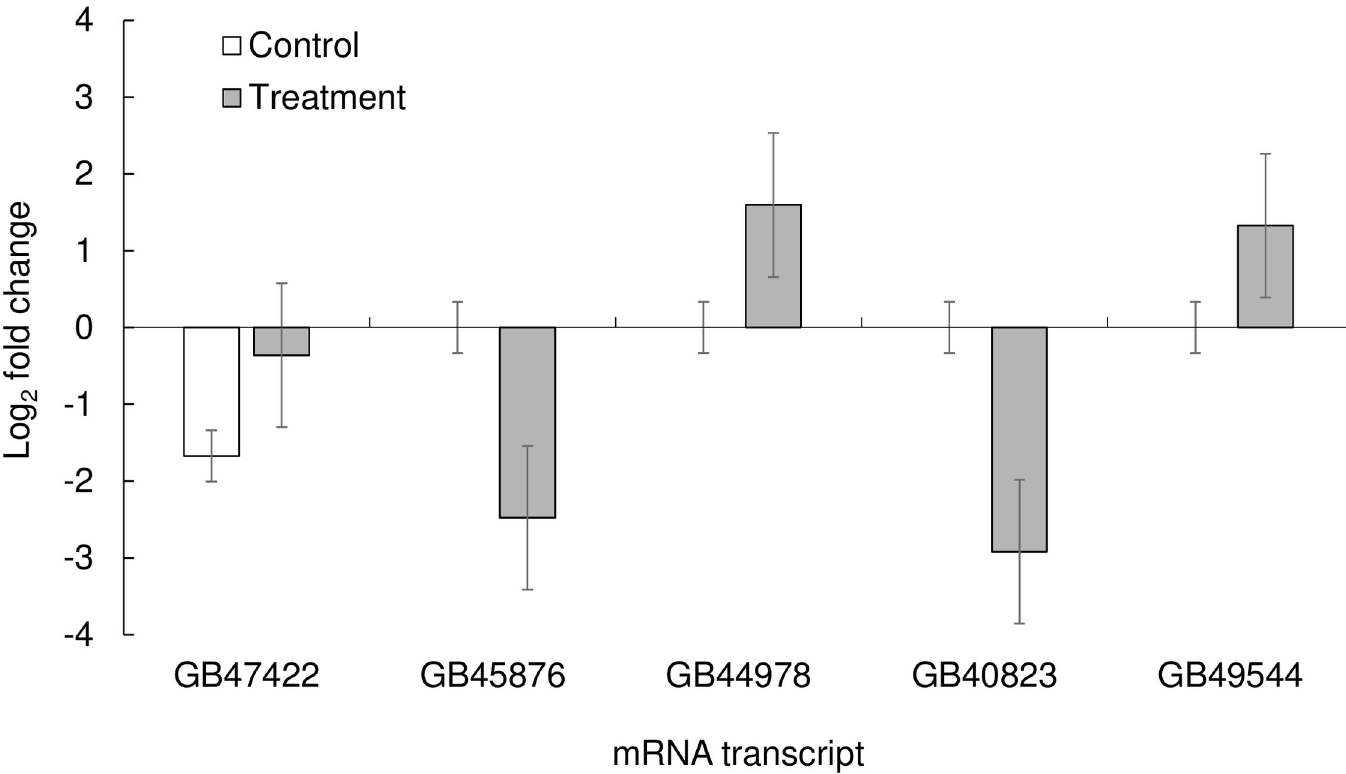
Fig 4. Log 2 fold change of the relative expression of five individual genes when comparing the expression of each gene in the brain tissue from control queens (those that were reared in pesticide-free wax) relative to the expression of the housekeeping gene AF441189 ( Apis mellifera ribosomal protein 49) (white bars), or the expression of each gene in the brain tissue from queens that were reared in amitraz-laden wax relative to the expression AF441189. Log 2 fold change values > 0 denote up-regulation, while values < 0 denote down-regulation. The BeeBase gene identifier was used for the Gene ID (Munoz-Torres et al. 2010).